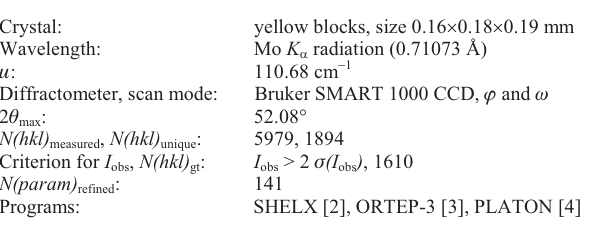
Table 1. Data collection and handling.